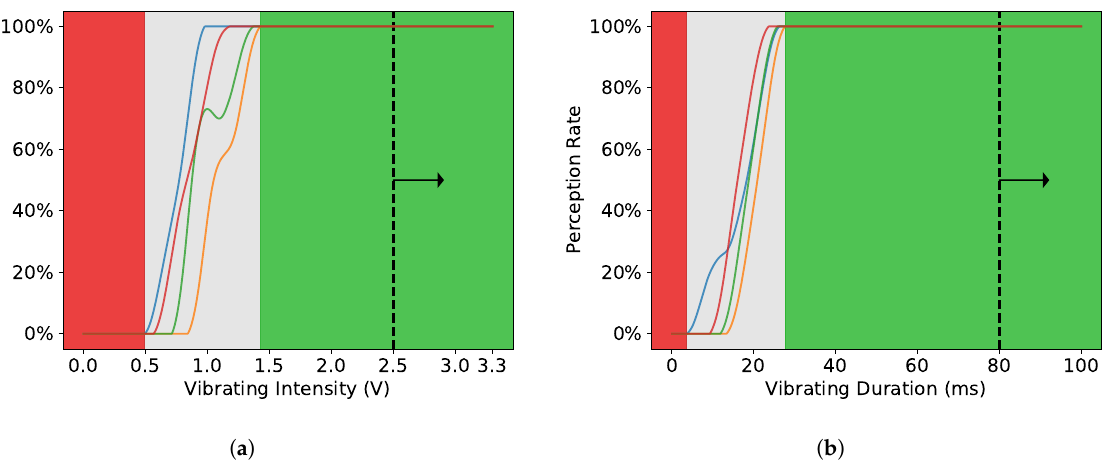
Figure 2. The sensitivity of neck skin to motor actuators in terms of vibrational intensity and duration. The gray region signifies uncertain range, in which the corresponding parameter setting would elicit either positive responses (“yes”) and negative responses (“no”) in the practical trials. All the responses in the red region were negative, while all the responses in the green region were positive. ( a ) Sensitivity in terms of intensity among all subjects. ( b ) Sensitivity in terms of duration among all